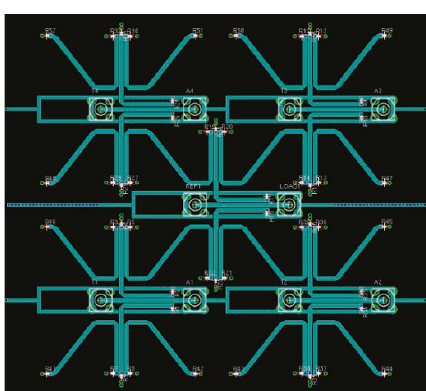
Figure 15: The PCB layout of the centre stripline controlled impedance conductor